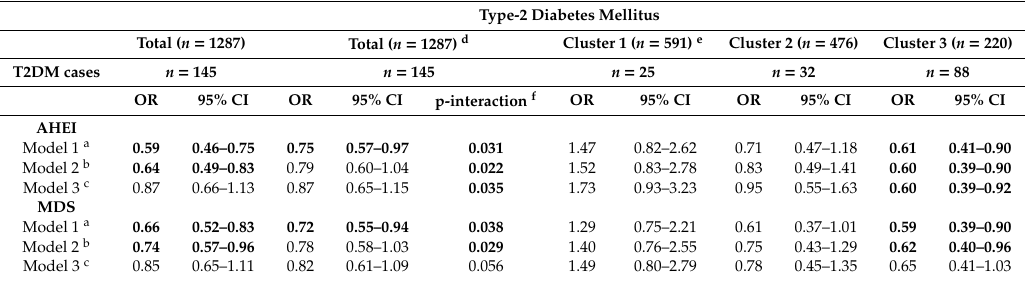
Table 4. Associations Between Diet and T2DM in the Total Sample, Stratified by